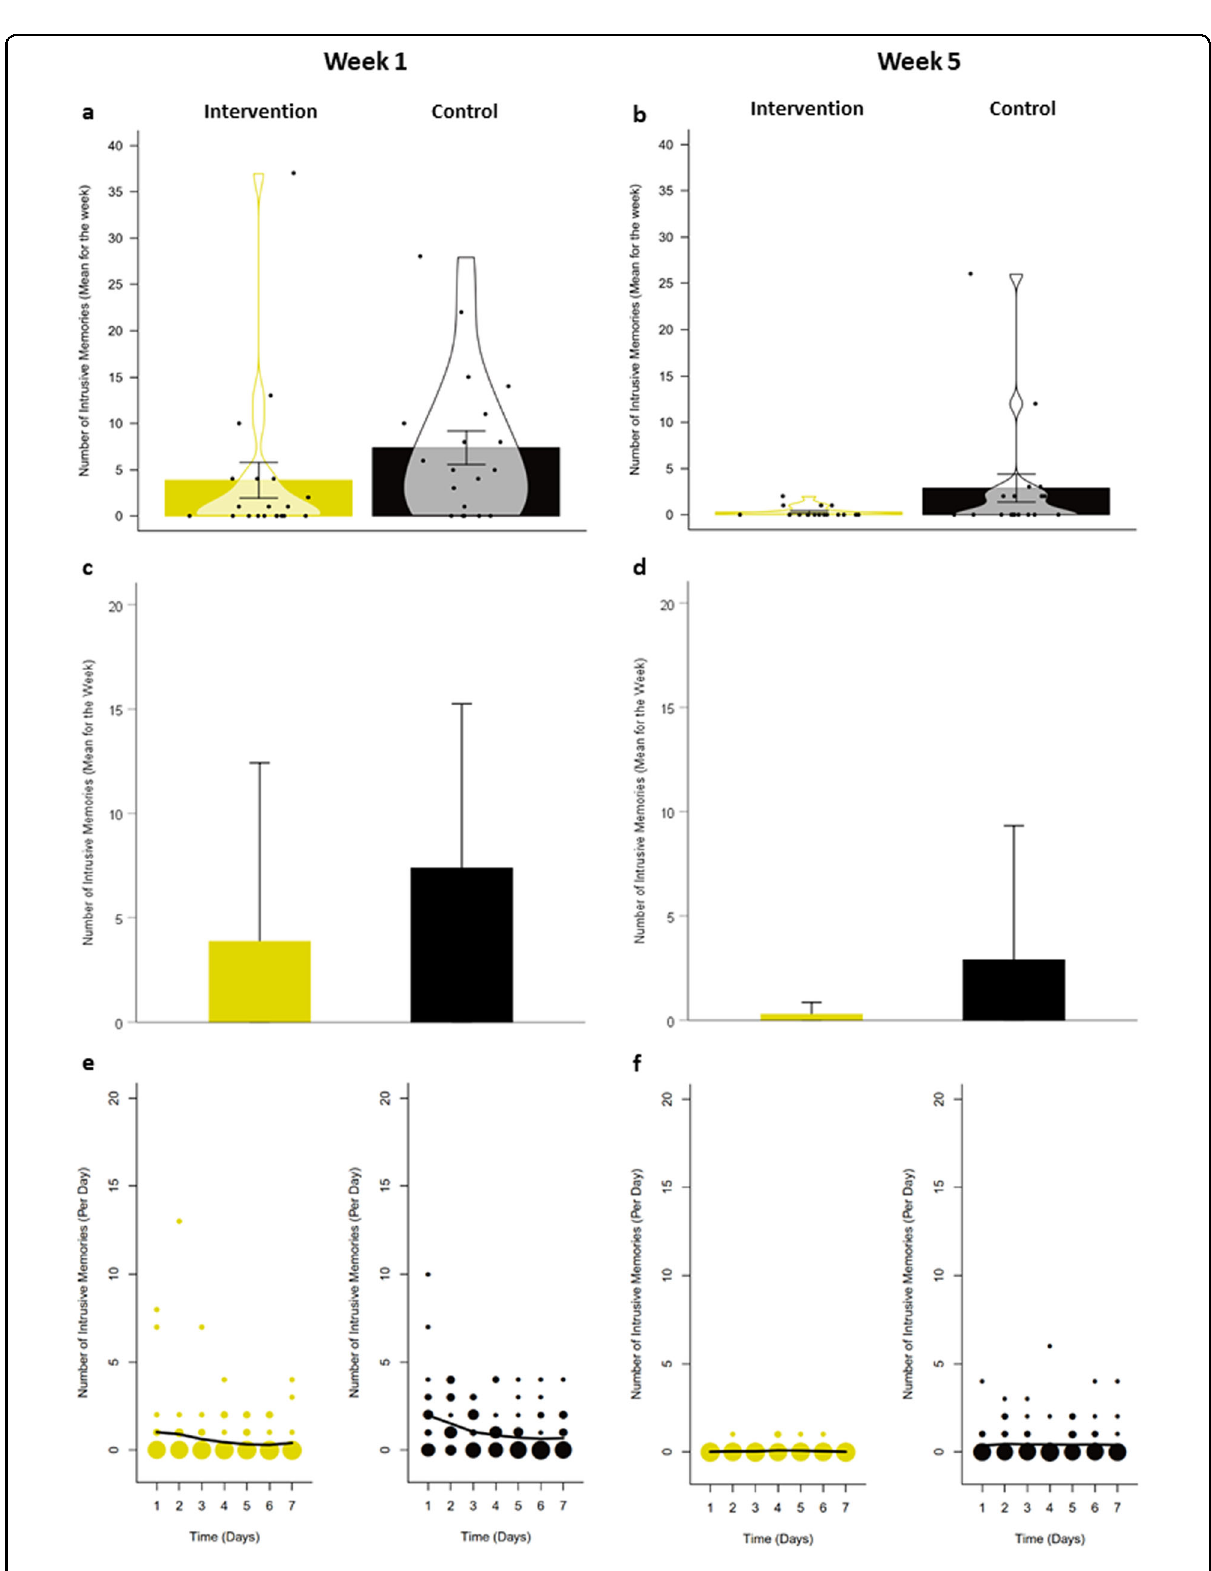
Fig. 2 (See legend on next